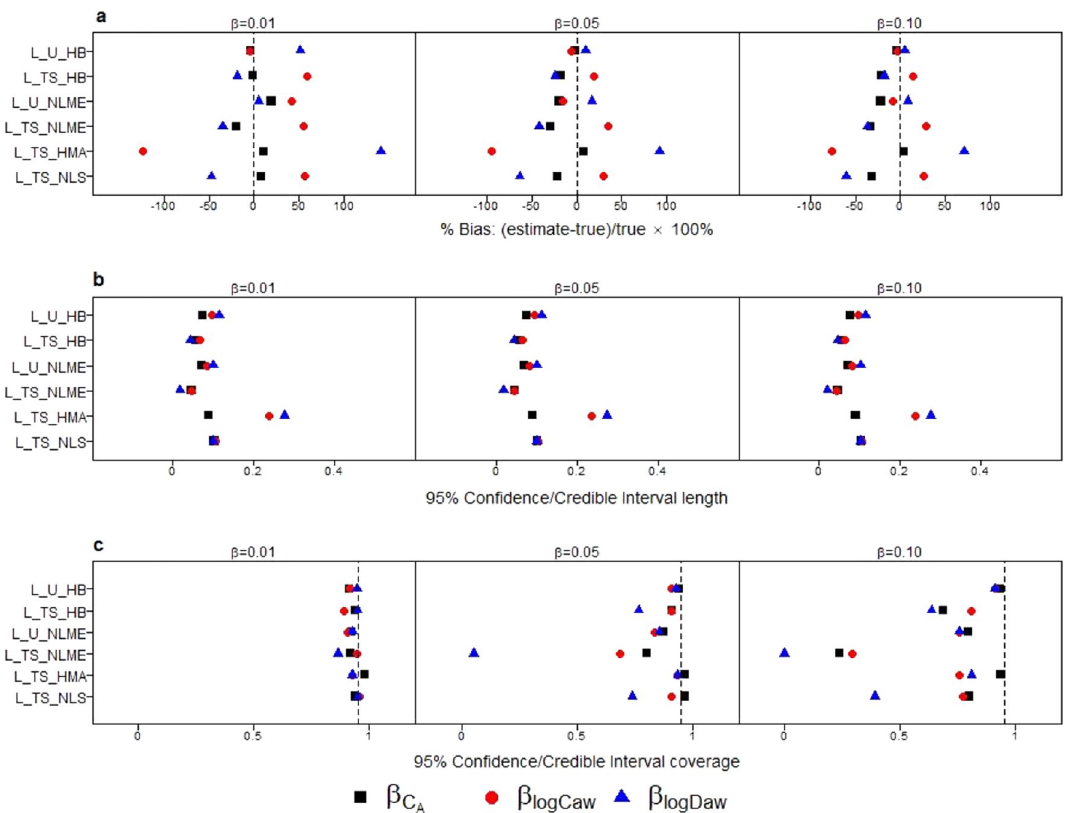
Figure 2. Comparison of method performance in terms of: percent bias ( a ), 95% CI length ( b ), and 95% CI coverage ( c ) for estimating associations with NO parameters ( β Ca : black square, β logCaw : red circle, β logDaw : blue triangle) in simulation study Scenario 1, replicated at 3 different effect sizes ( β = 0.01, 0.05 or